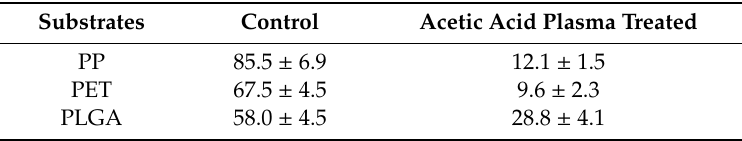
Table 1. Wettability of acetic acid plasma-treated substrates.